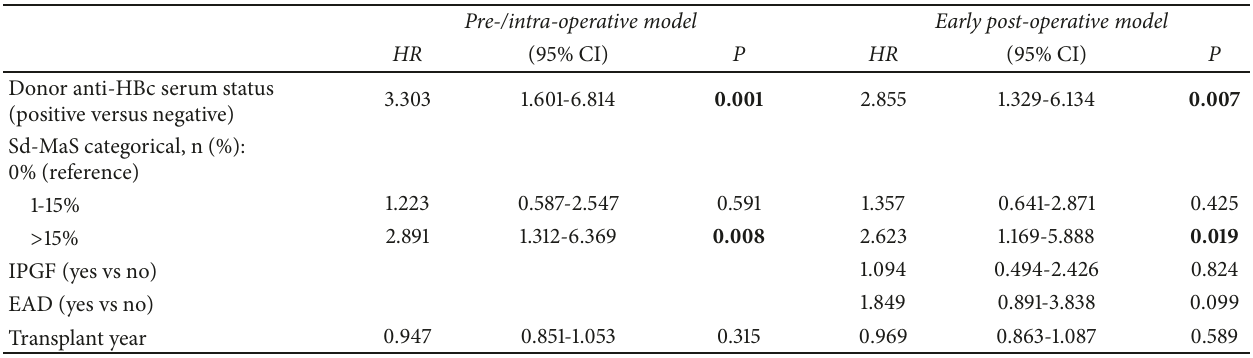
Table 3: Multivariable Cox regression models for overall graft loss in recipients with HCV negative liver disease.